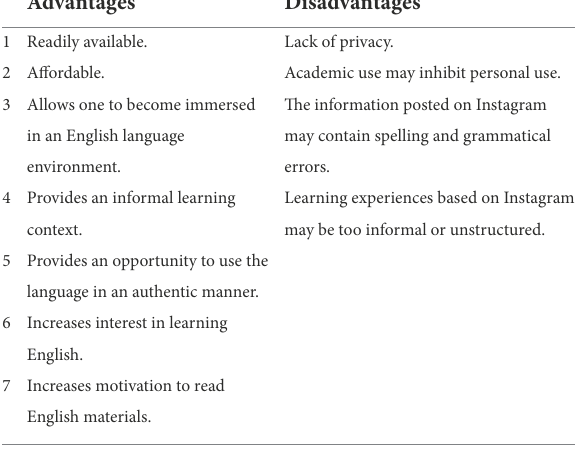
TABLE 1 Perceived advantages and disadvantages of using Instagram to learn